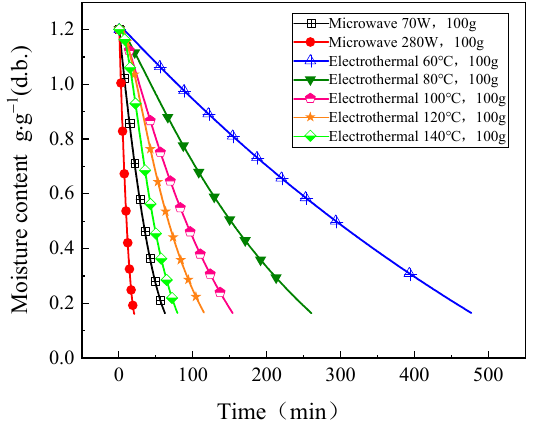
Figure 8. Comparison of moisture content curves between microwave drying and electrothermal drying.